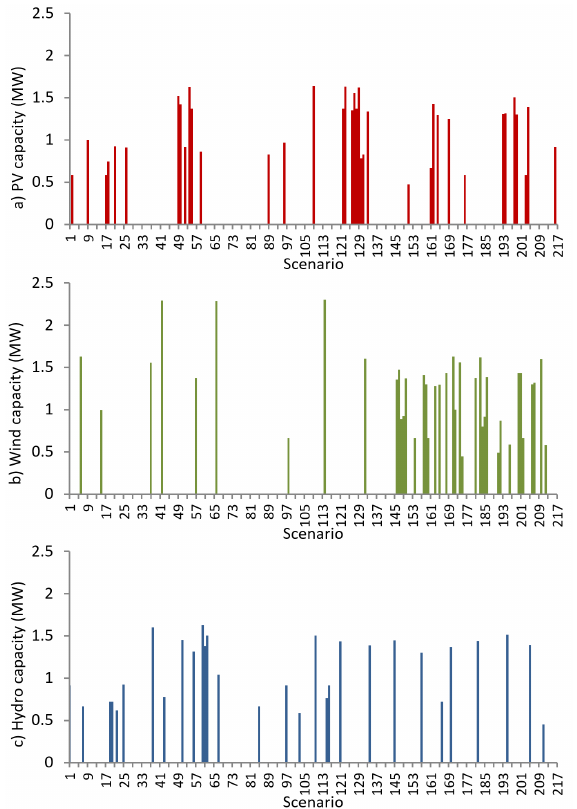
Figure 7. Sensitivity analysis regarding different RES type installation for node 6 (33 bus system): ( a ) PV ( b ) WP ( c )